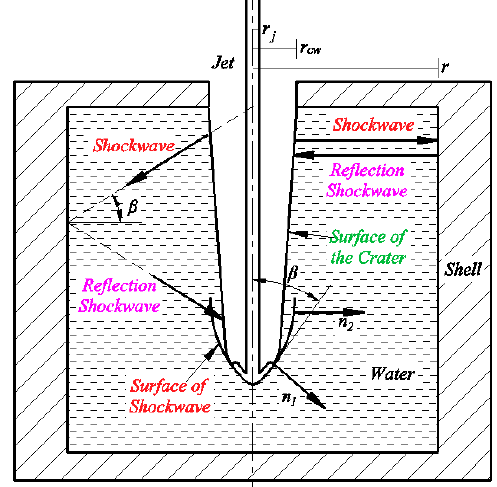
Figure 2. Schematic of the shock wave side-wall reflection in liquid.